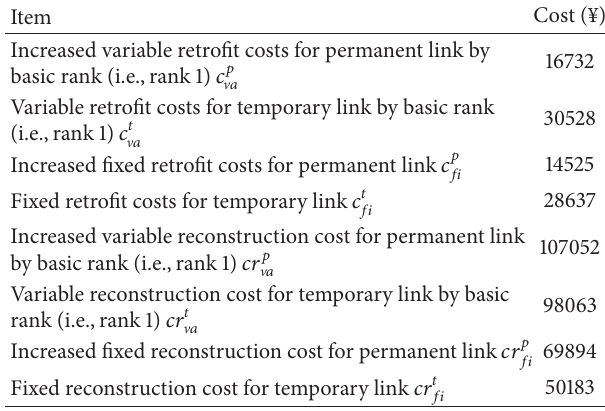
Table 5: Cost data of retrofit and